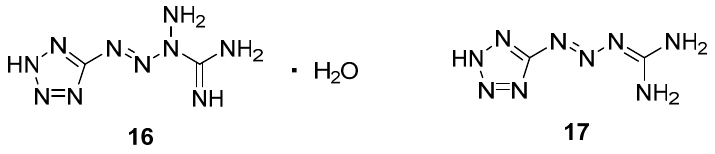
Figure 2. Molecular structure of tetrazene (16) and MTX-1 (17).